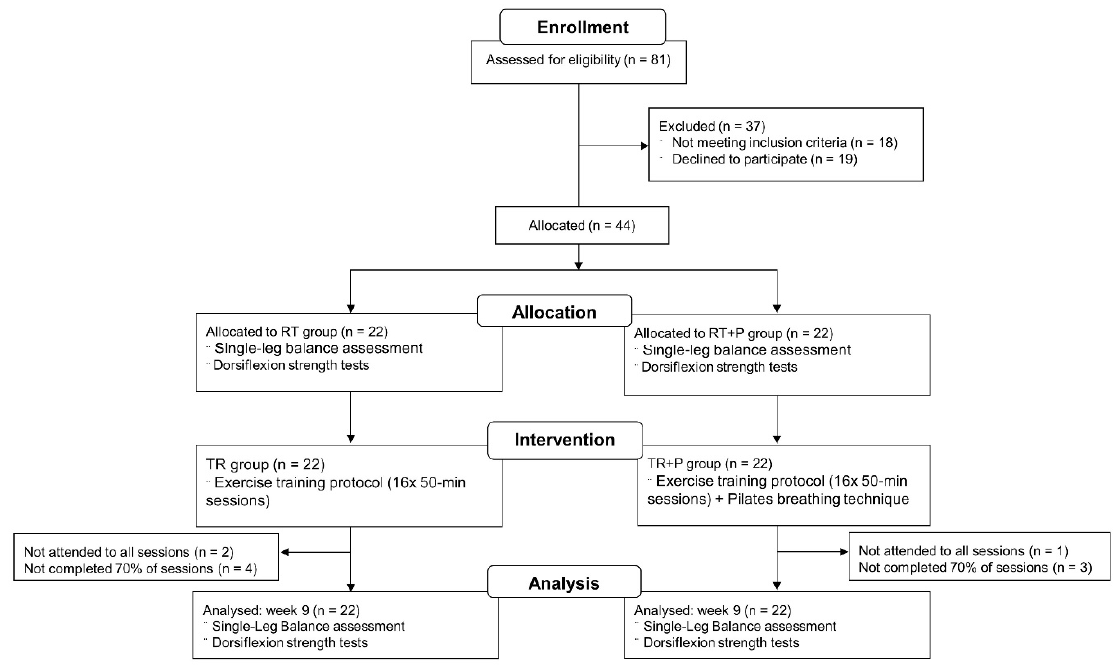
Figure 3. Flow chart. RT: resistance training; RT + P: resistance training with Pilates breathing tech- nique.